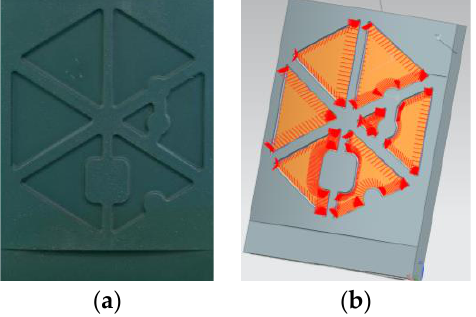
Figure 3. Local pattern features of aeroengine casing and Second scribing trajectory. ( a ) Local pattern features of aeroengine casing; ( b ) Second scribing trajectory of aerospace parts local features.